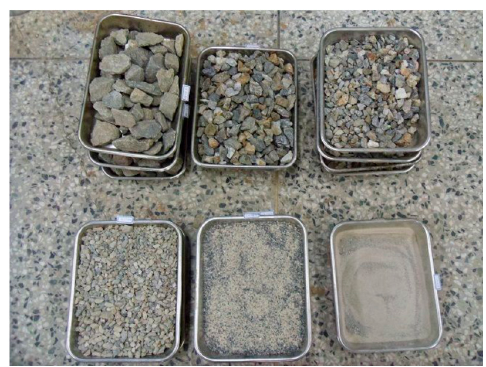
Figure 1. Sieved gravel ballast samples. Largest size on top left and smallest one on bottom right.